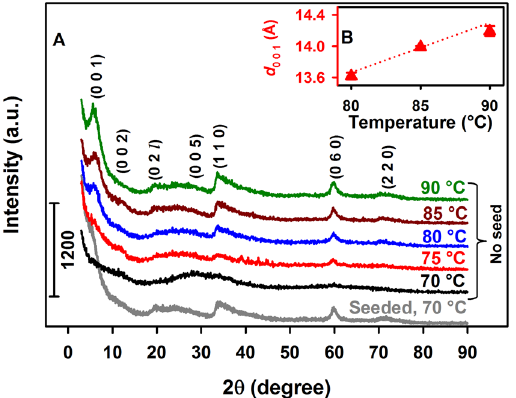
Figure 2. Powder XRD and d 0 0 1 values for 2:1 sauconite synthesized at pH 0 6.3 with 0.10 M succinate during 20 h under variable temperature. ( A ) XRD diffractograms under the temperatures listed above each trace. The gray line at the bottom labeled “seeded” corresponds to an experiment at 70 °C started after adding a single particle from sauconite synthesized at 90 °C. An oval shaped particle weighing 0.7 ( ± 0.1) mg and symmetry axes of length 313 ( ± 9) and 144 ( ± 7) µ m was used for seeding. ( B ) Values of d 0 0 1 (red solid triangle) for traces in (A) with no seed vs